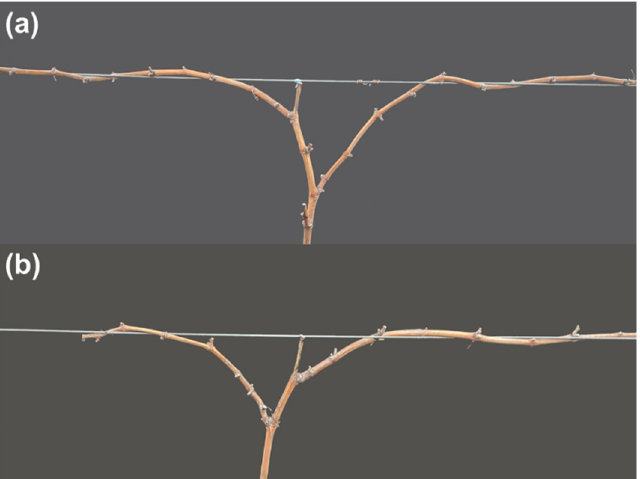
Figure 2. Length adjustment of low-vigour canes selected as permanent cordon arms. ( a ) Both canes selected as permanent cordon arms were deemed suitably high vigour and did not receive a length adjustment; ( b ) one cane selected as a permanent cordon arm was deemed to have an apparent vigour too low to support uniform budburst and shoot growth and received a length adjustment based on its apparent vigour.